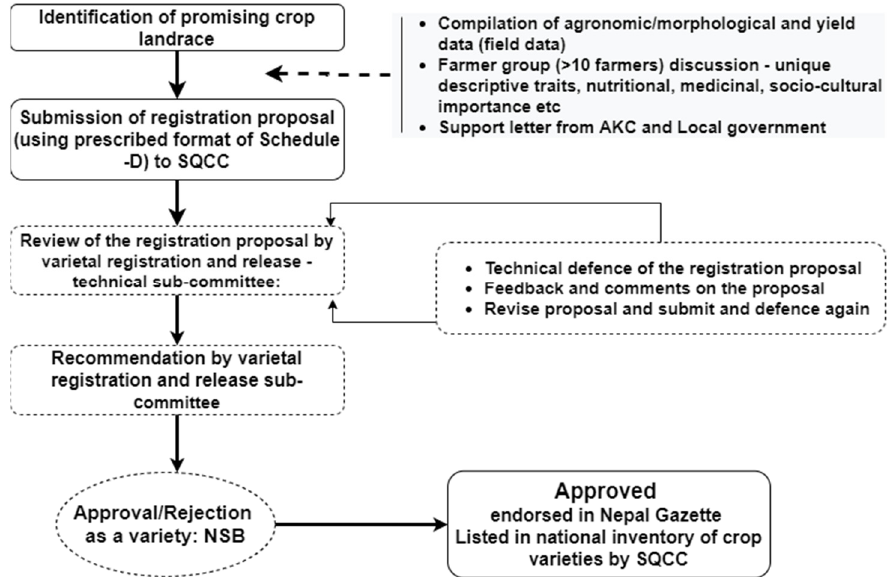
Figure 5. Process for registration of farmers’ varieties in Nepal (Source: the authors).